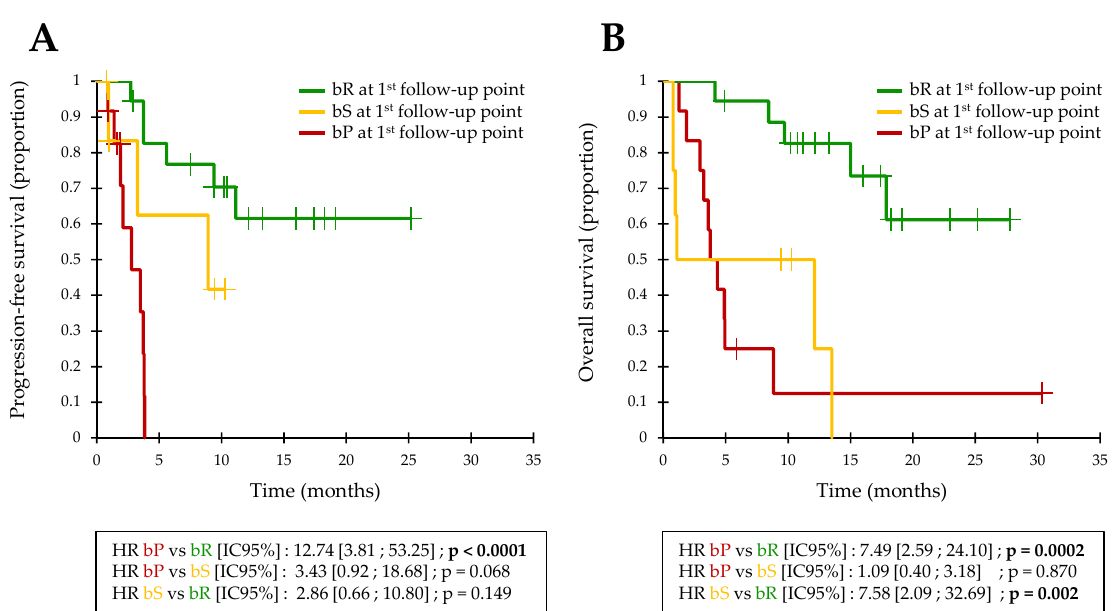
Figure 2. Kaplan-Meier estimate of the PFS ( A ) and OS ( B ) in pooled analysis, based on the biological response assessment at the first follow-up point.